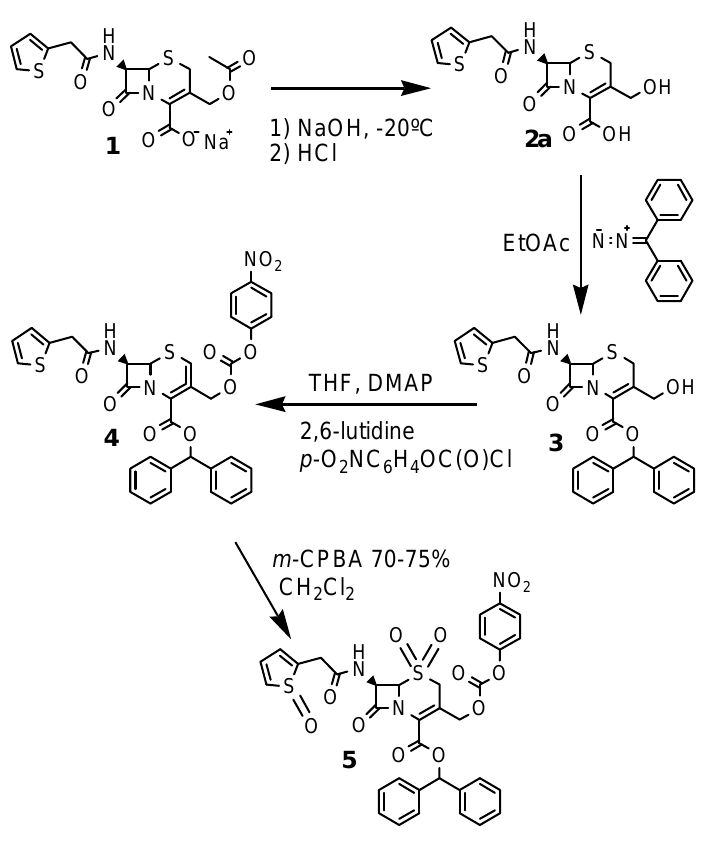
Scheme 1. Synthesis of the cephalothin derivative 5 .